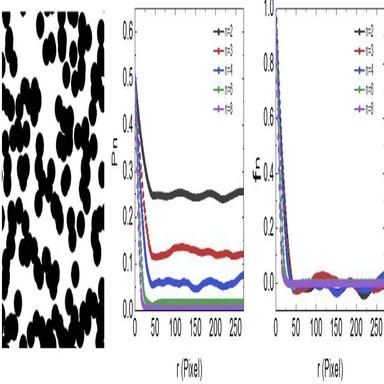
(a) 2D microstructure composed of equal-sized overlapping spheres in a matrix. (b) The Pn functions for the particle phase with n ¼ 2, 3, 4, 6 and 8. (c) The corresponding rescaled fn functions highlighting the spatial correlations (c.f. Eq.).